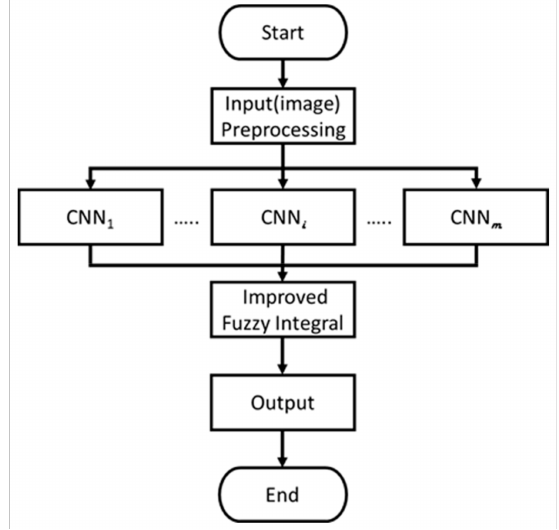
Figure 1. Structure of